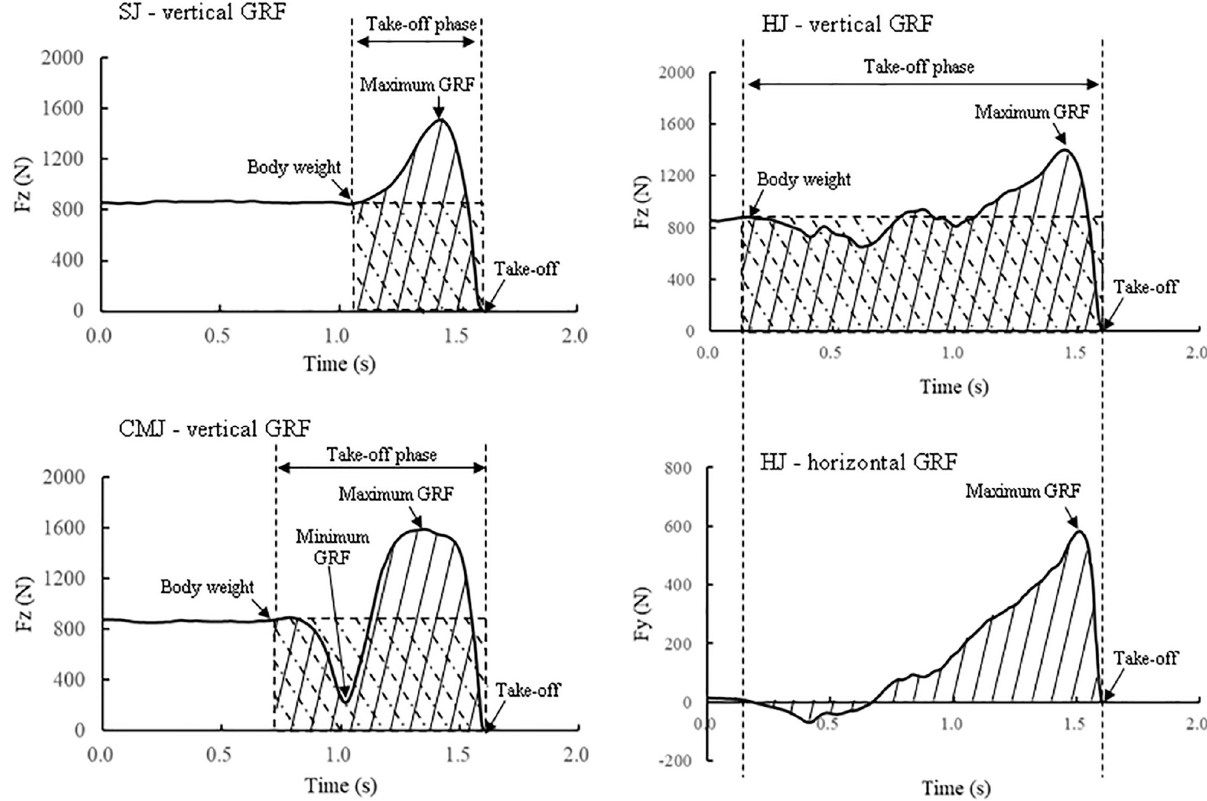
Fig 2. Typical raw data of ground reaction force during the squat jump (SJ), countermovement jump (CMJ) and horizontal jump (HJ) under barefoot conditions. Take-off phase: The range from the onset of the vertical GRF change to the take-off during the ground contact of the SJ, CMJ and HJ; Fz_max: Maximum vertical ground reaction force; Fz_mini: Minimum vertical ground reaction force; Fy_max: Maximum horizontal ground reaction force; VI (grey area): Net vertical impulse; HI (grey area): Net horizontal impulse.